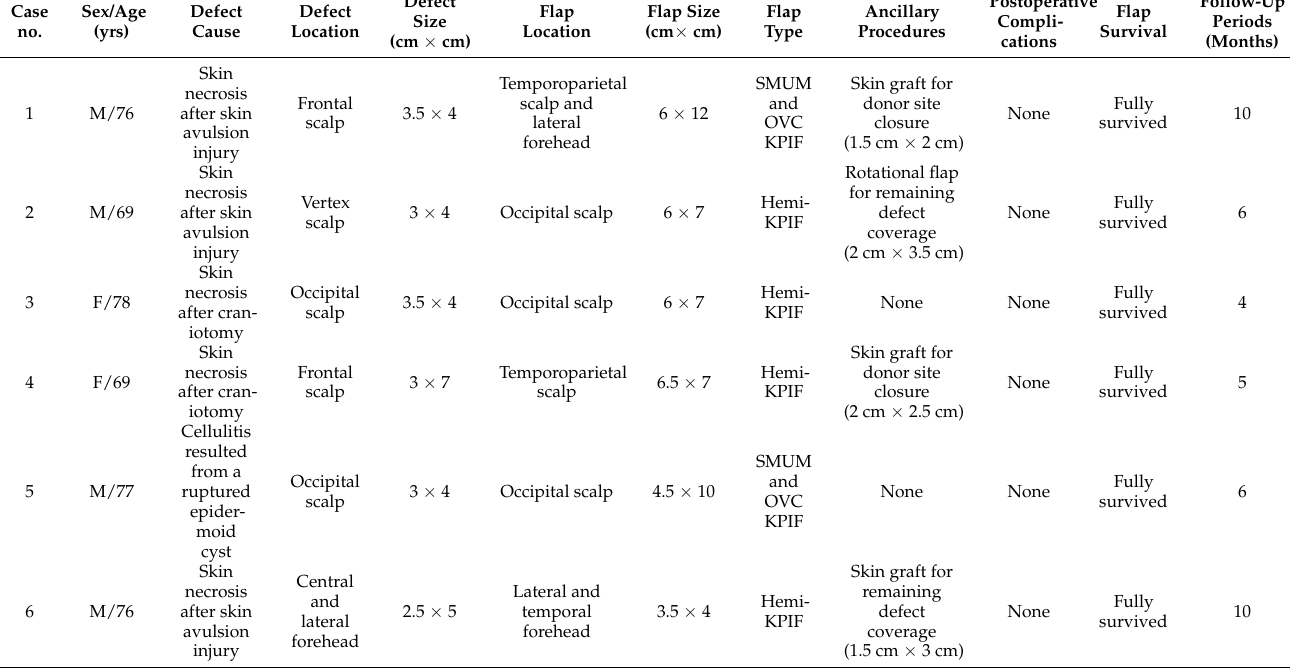
Table 1. Summary of patients’ data and